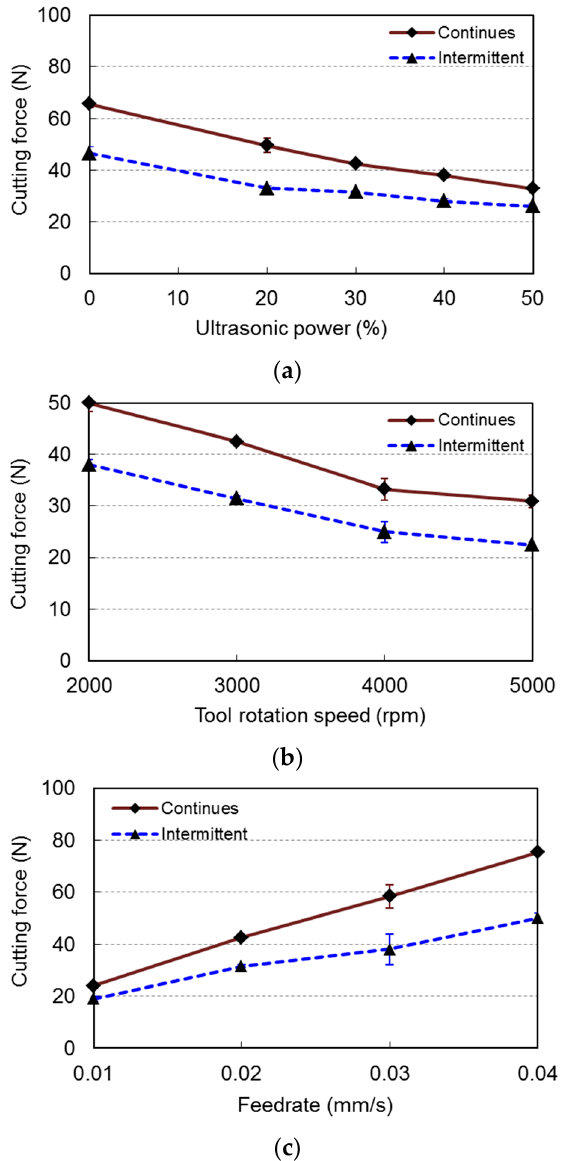
Figure 6. Effects of input variables on cutting force. ( a ) Effects of ultrasonic amplitude; ( b ) Effects of tool rotation speed; ( c ) Effects of federate.